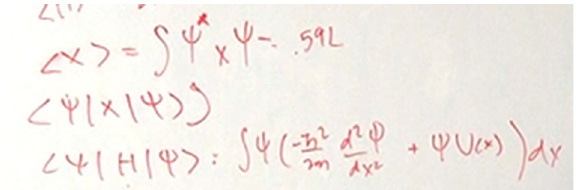
FIG. 7. Student work showing the use of Dirac notation when setting up